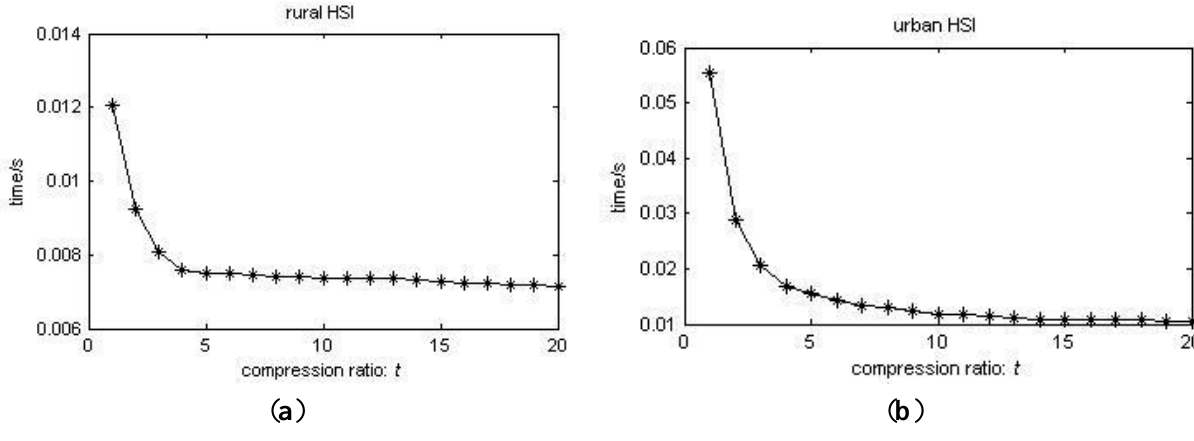
Figure 10. ( a ) Rural HSI: runtime of the proposed method as a function of compression ratio t ; ( b ) Urban HSI: runtime of the proposed method as a function of compression ratio t